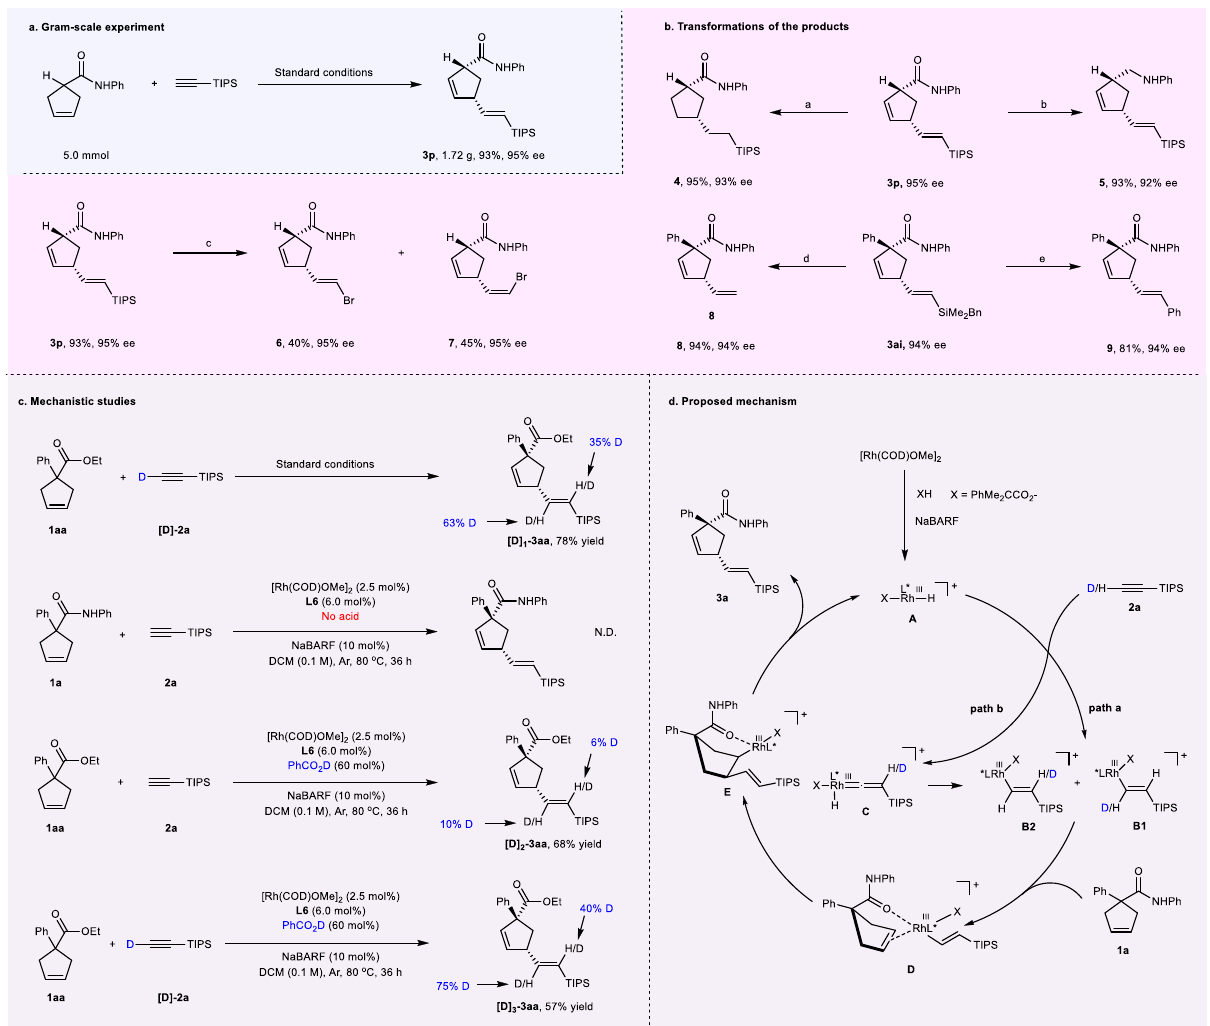
Fig. 3 Further studies on the reaction. a Gram-scale experiment. b Transformations of the products. a Pd/C (10 wt %), B 2 (OH) 4 , H 2 O, DCM, rt. b LiAlH 4 , 1,4-dioxane, 0 o C-80 o C, 15 h. c NBS, Ag 2 CO 3 , HFIP, rt, 2 h. d TFA, DCM, 60 o C, 12 h. e Pd(dba) 2 , TBAF·3H 2 O, Iodobenzene, THF, rt, 24 h. c Mechanistic studies. d Proposed